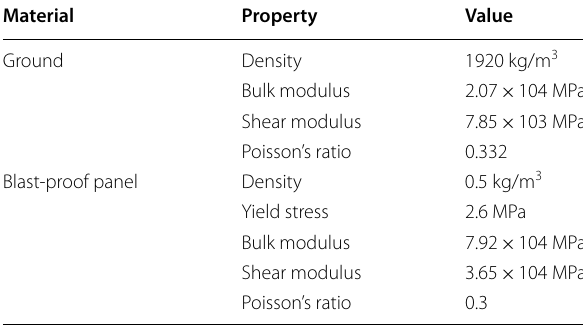
Table 2 Material properties of concrete used in simulation Property